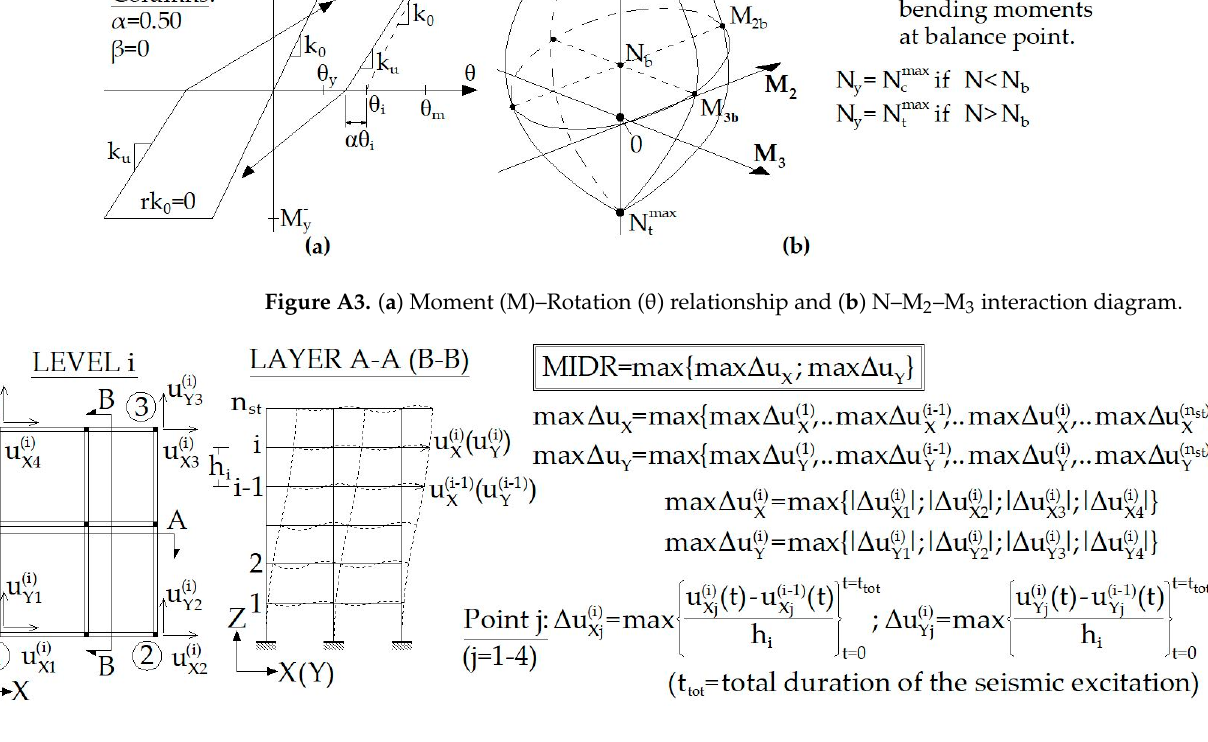
Figure A4. Calculation of the MIDR value in the case of an n-story building with arbitrary plan view. Table A1. Data of the 65 selected seismic Table A1. Data of the 65 selected seismic excitations.